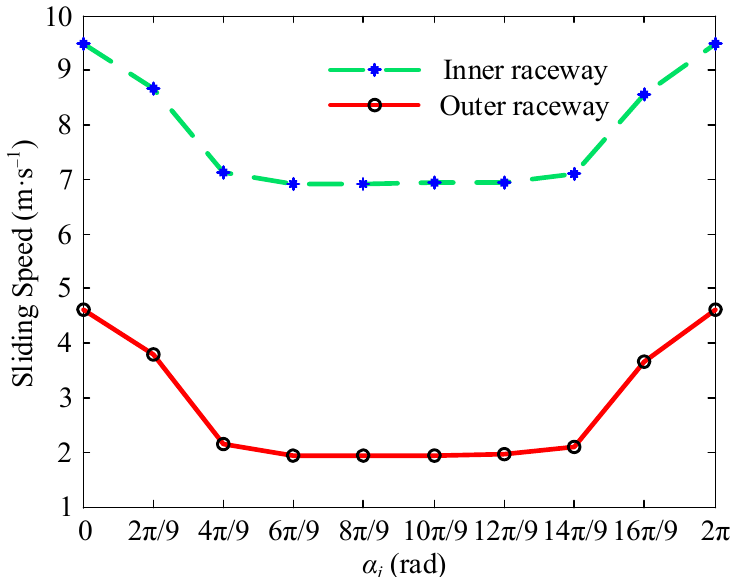
Figure 8. Sliding speed between the ball and the inner raceway and outer raceway.